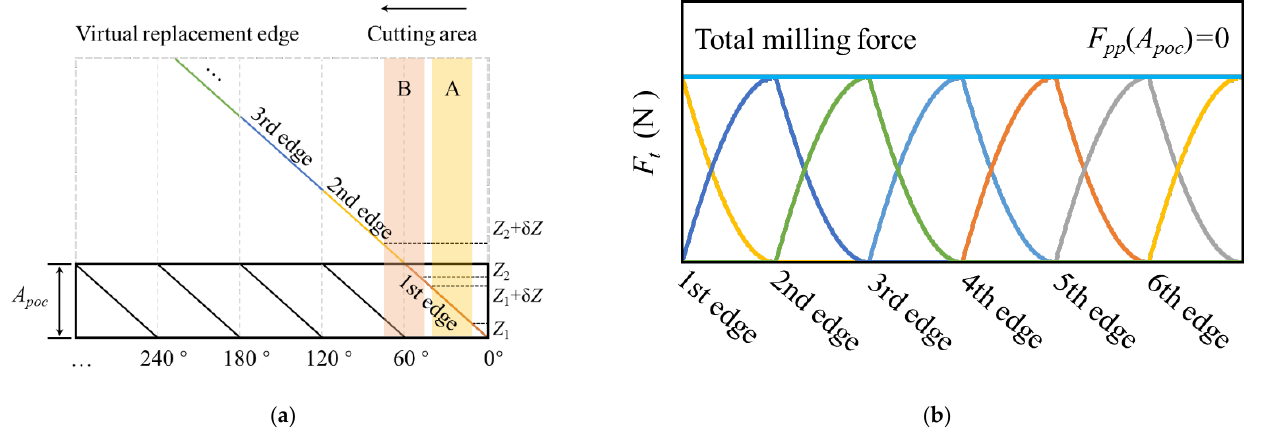
Figure 4. The uniformity characteristics of force fluctuation: ( a ) virtual-edge projection and ( b ) the force fluctuation of uniformity milling.